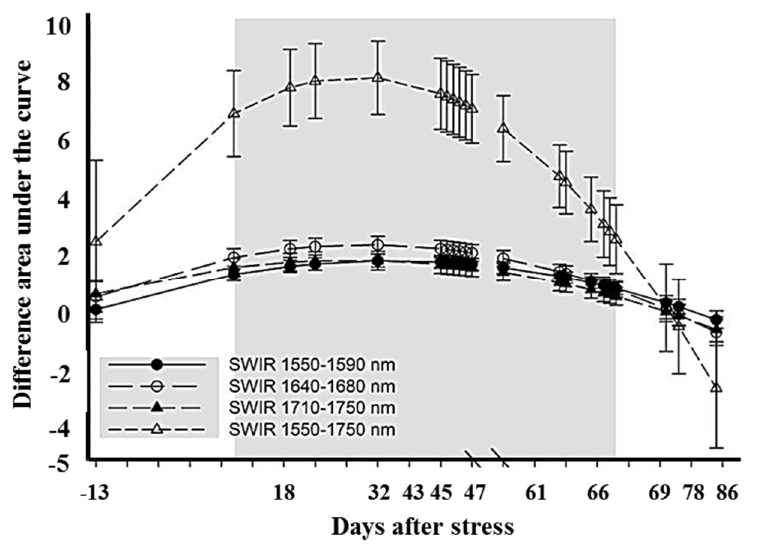
Figure 7. Model-based estimated difference for the area under the curve for SWIR regions 1550–1590, 1640–1680 and 1710–1750 nm, each with a distance of 40 nm, and 1550–1750 nm with a distance of 200 nm. The shaded area shows the time points that were statistically different. The break in the horizontal axis between 47 and 52 days after stress separates the period of water stress from recovery. Error bars are the standard errors; n =